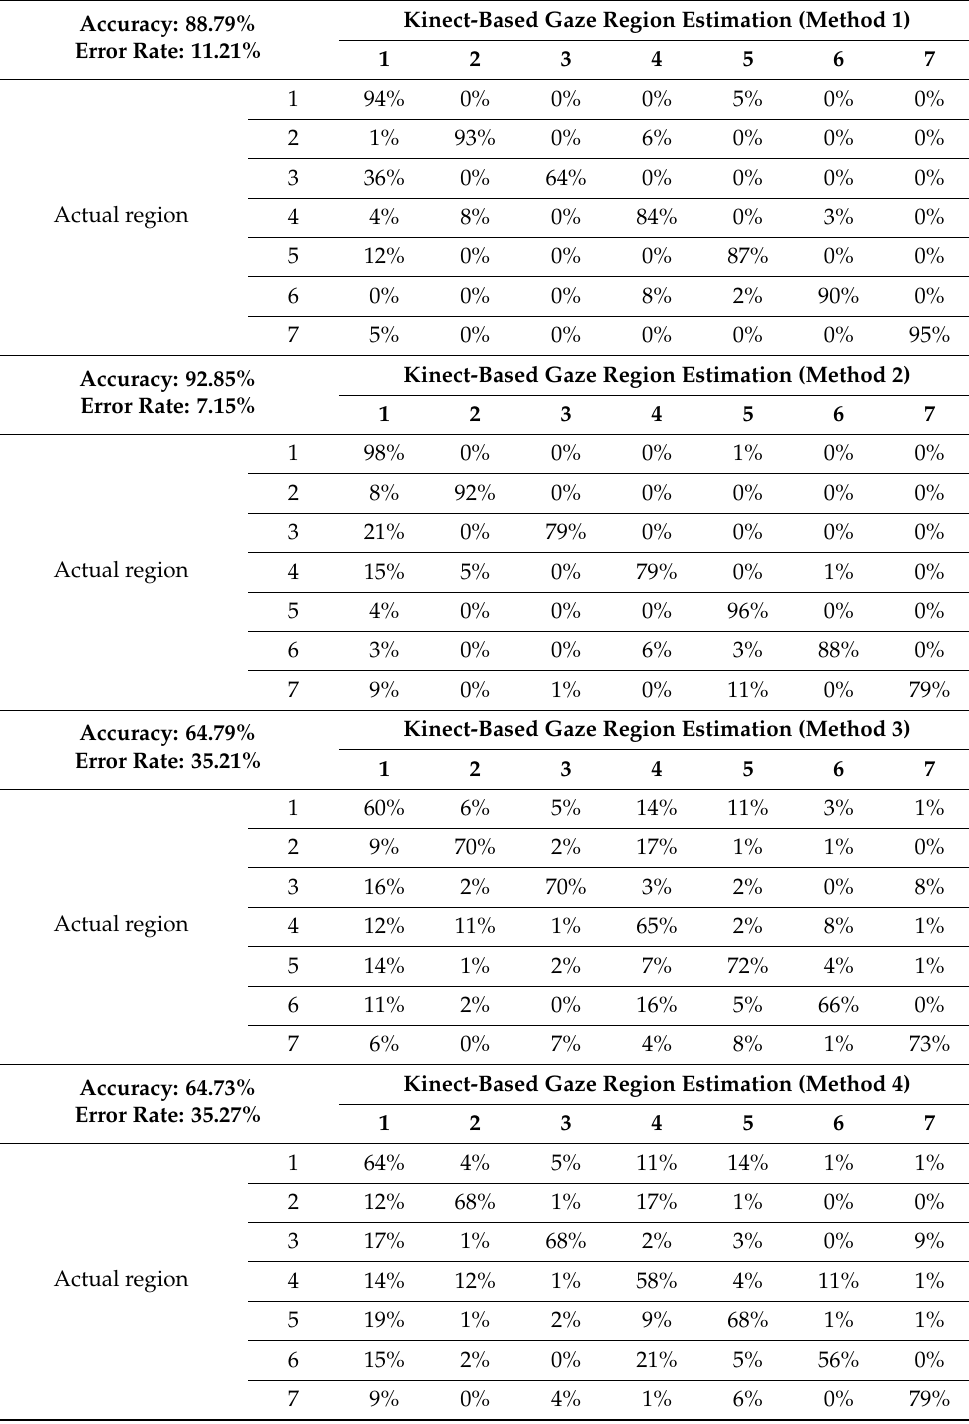
Table 3. Confusion matrices using Kinect for each of the four developed methods. Accuracy: